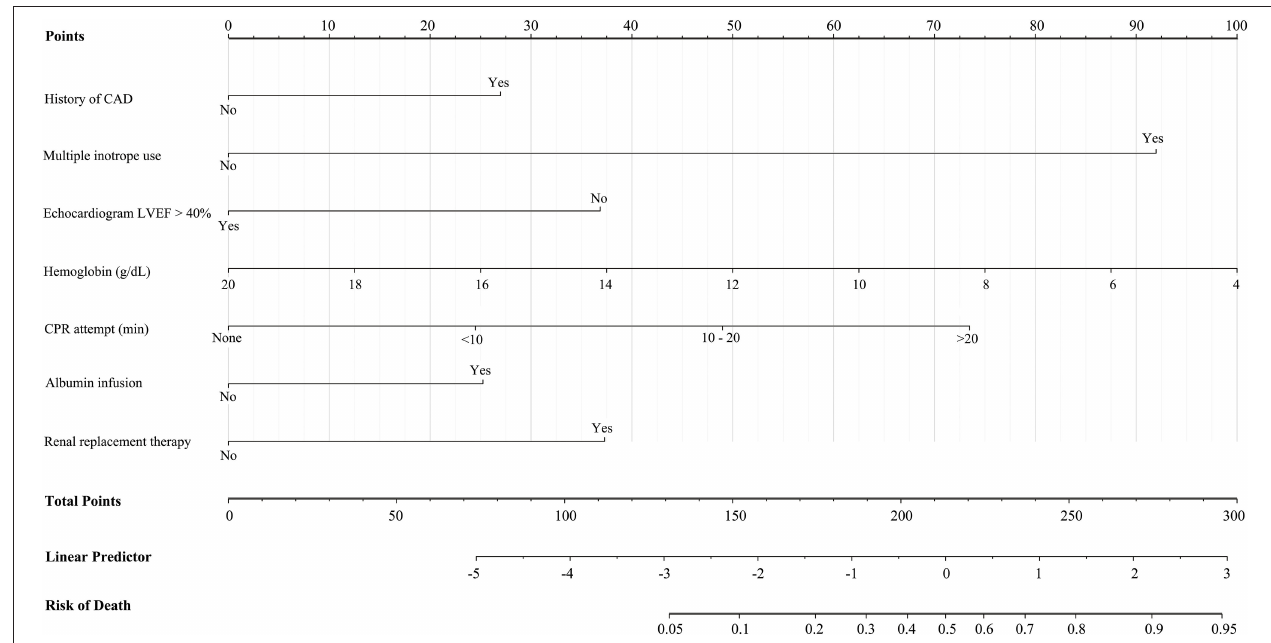
FIGURE 2 | The Cardiogenic Shock Prognosis score, a predictive nomogram of in-hospital mortality for patients with cardiogenic shock. CAD, coronary artery disease; CPR, cardiopulmonary resuscitation; LVEF, left ventricular ejection